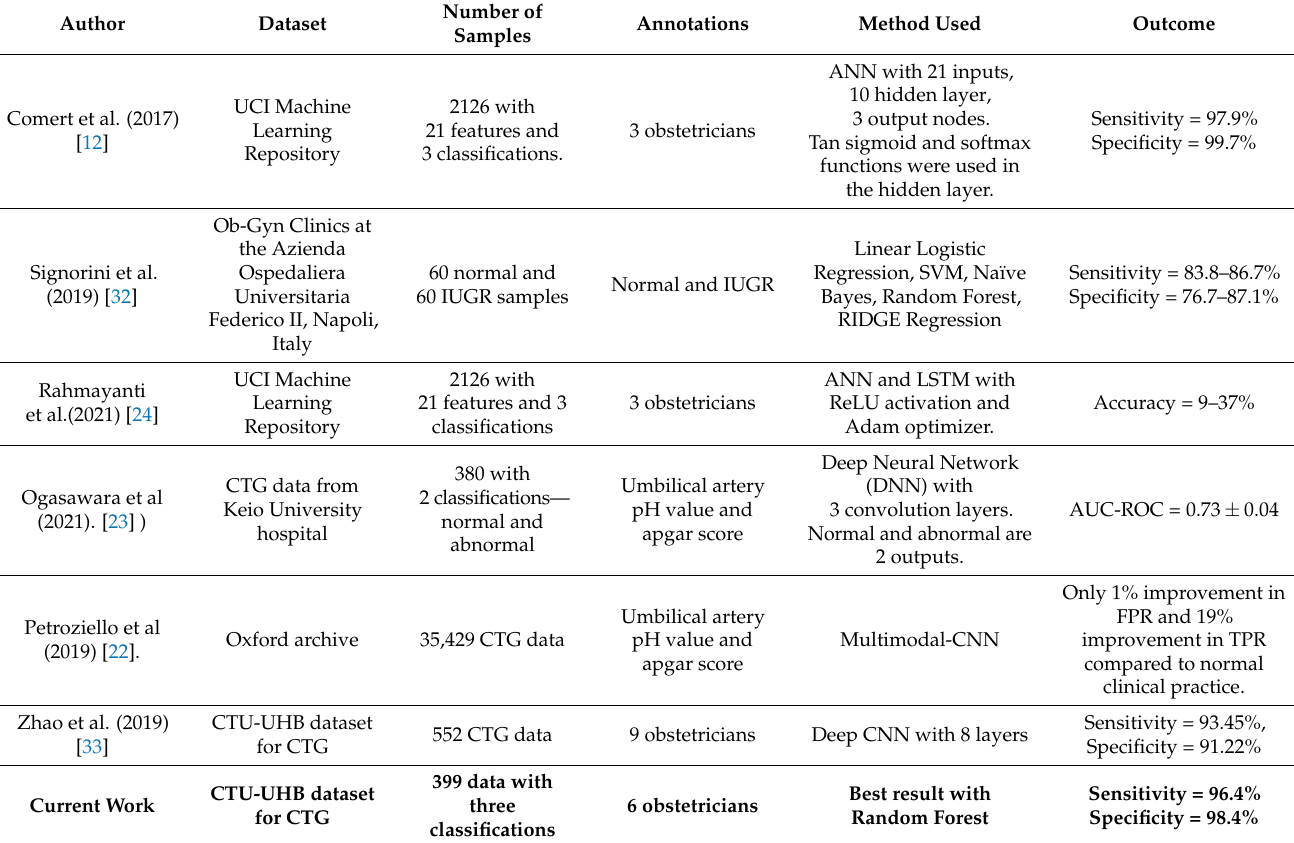
Table 11. A comparison with some of the recent works for the classification of